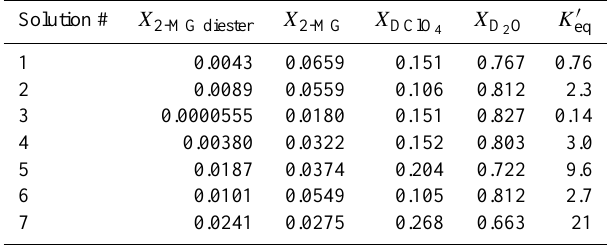
Table 6. Equilibrium mole fraction composition for perchloric acid controlled composition experiments. Sum of listed mole fractions not equal to unity due to presence of NaClO 4 and trace